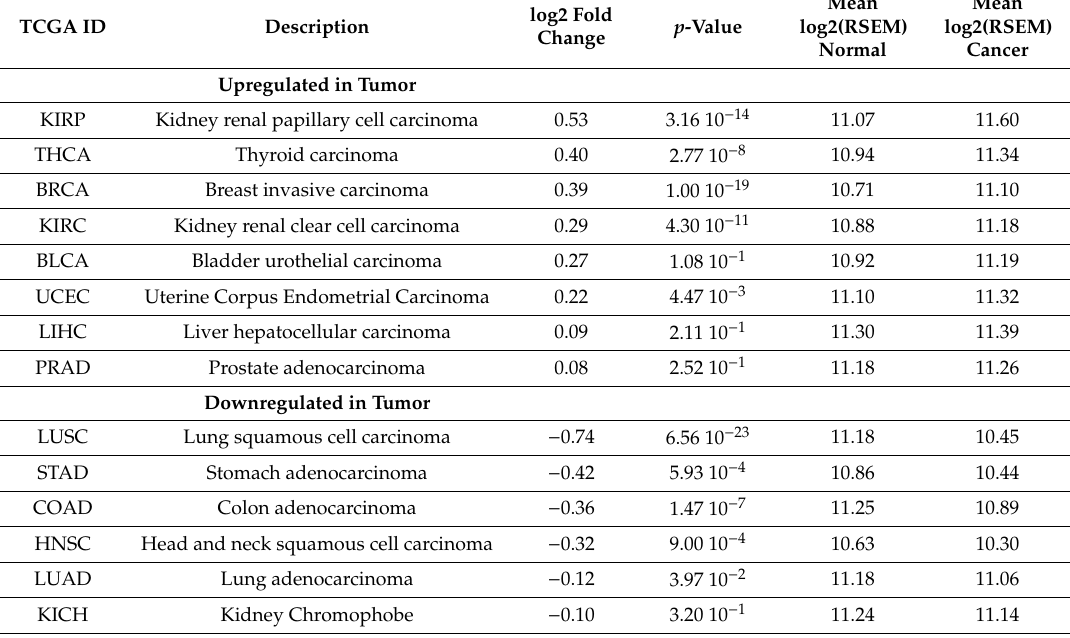
Table 2. Di ff erential expression of TMEM219. “Mean log2 (RSEM)”—average gene expression in normal and cancer tissues, respectively. t -test p -values are